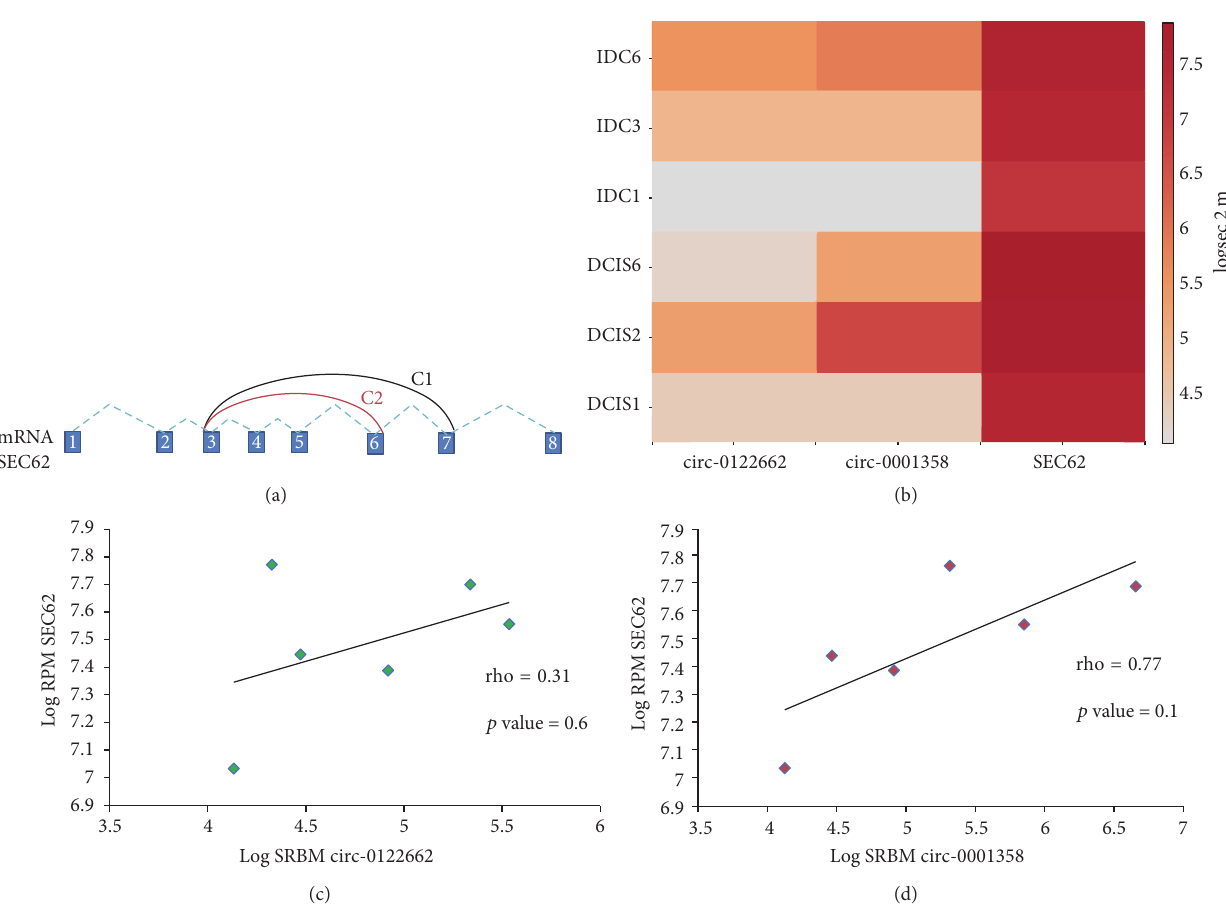
Figure 2: Schematic illustration of the two circRNAs C1 (hsa-circ-0001358) and C2 (hsa-circ-0122662) produced by the pre-mRNA of SEC62 gene. The heatmap showed the log expression values of the hsa-circ-0122662, hsa-circ-001803, and SEC62 in the two paired samples and two unpaired (b). The scatterplot showed the correlation between SEC62 ( 𝑦 -axes ) and the two circular RNAs, respectively ( 𝑥 -axes ): hsa-circ- 0122662 and hsa-circ-0001358. Rho and 𝑝 values were obtained performing a Spearman rank test (c and